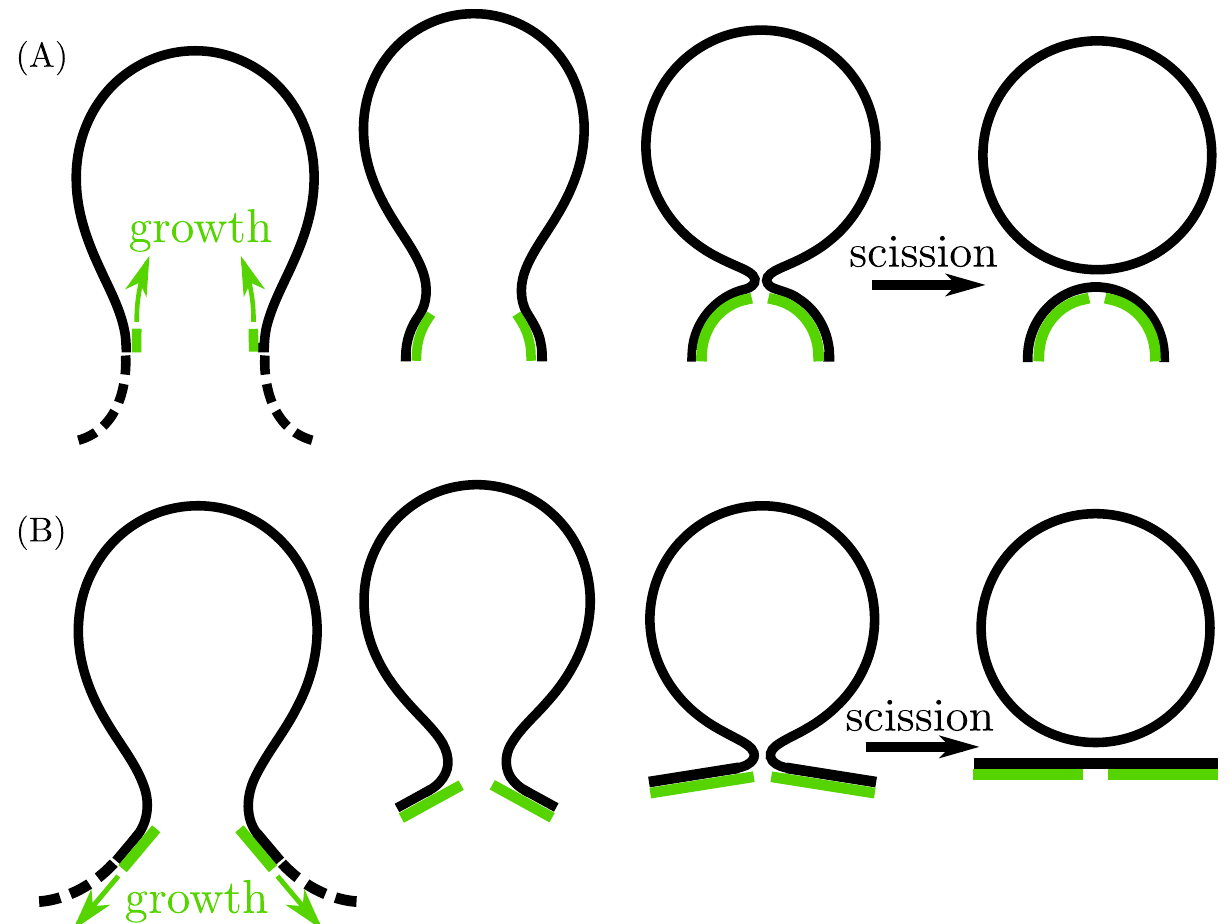
Fig 1. Proposed mechanisms for adhesion-induced fission consisting of neck closure and scission by dome-shaped and cone-shaped ESCRT complexes. (A) In the dome model, the ESCRT-III complex (green) first assembles at the neck of a nascent bud, and then grows towards the bud, forming a hemispherical dome. Because of membrane–protein adhesion, the membrane (black) follows the growth of the dome until the diameter of the neck becomes comparable to the membrane thickness, and the neck can undergo scission. (B) In the flattening cone model, the ESCRT-III complex first assembles at the neck of the nascent bud, and then grows away from the bud in the shape of a cone. As the truncated cone grows beyond a critical size, it flattens, leading to closure and scission of the membrane neck. All cartoons represent axisymmetric geometries.